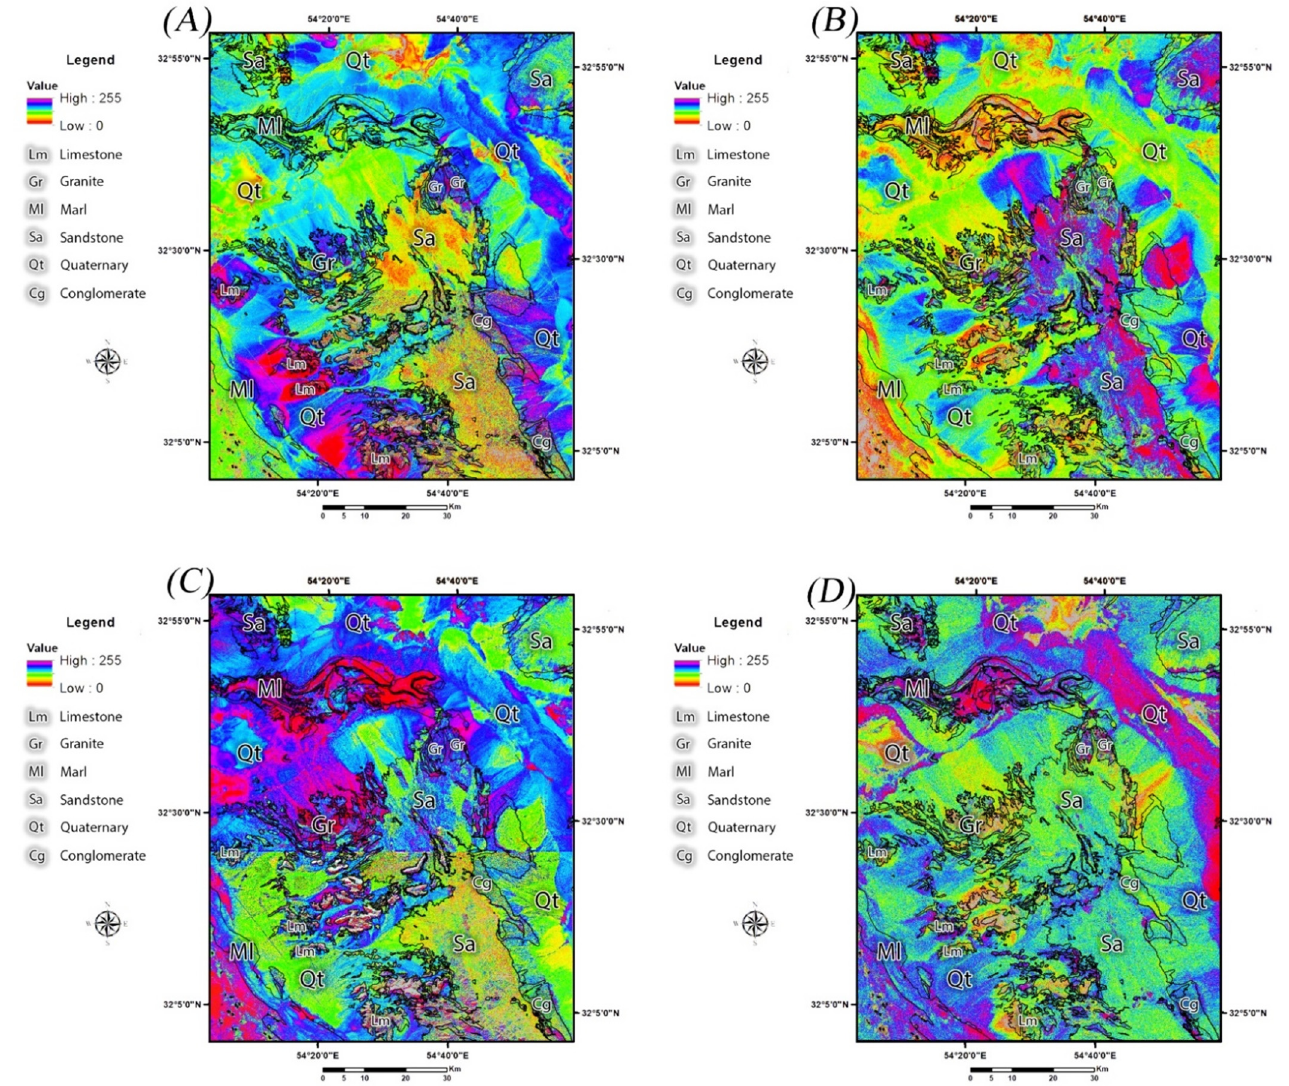
Figure 4. Spatial distribution of iron oxide/hydroxides and hydroxyl-bearing (Al-OH) alteration and carbonates in the study area as pseudo-color ramp. ( A ) 4/2 band ratio of Sentinel-2; ( B ) 1/3 band ratio of Landsat-7; ( C ) 11/12 band ratio of Sentinel-2; ( D ) 5/7 band ratio of Landsat-7. A PCA image with strong eigenvector loading for indicative reflection and absorption bands (in VNIR and SWIR regions) of a specific mineral or mineral groups (e.g., iron oxide/hydroxide minerals or clay minerals) with opposite signs detects that mineral/mineral groups as bright or dark pixels. If the eigenvector loading is positive in the reflection band of the target mineral the PCA image tone will be bright, and if it is negative, the PCA image tone will be dark for the target mineral [26]. The information typically characterizes in a very small fraction of the total information content for the original bands. After